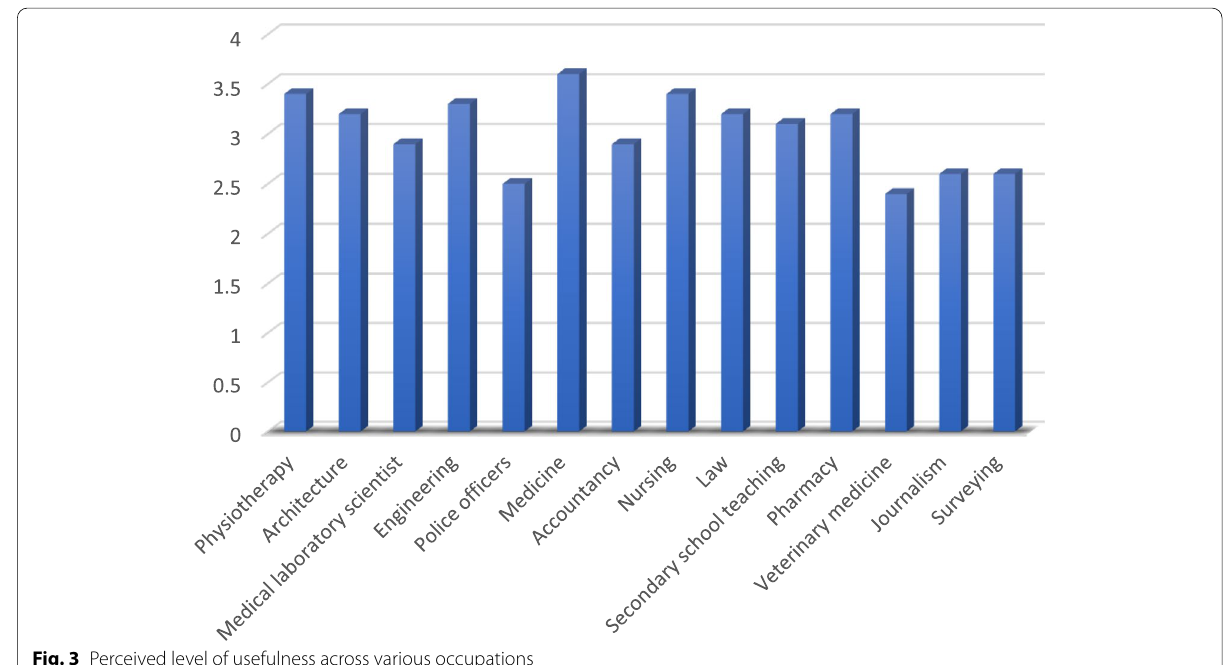
Fig. 3 Perceived level of usefulness across various occupations